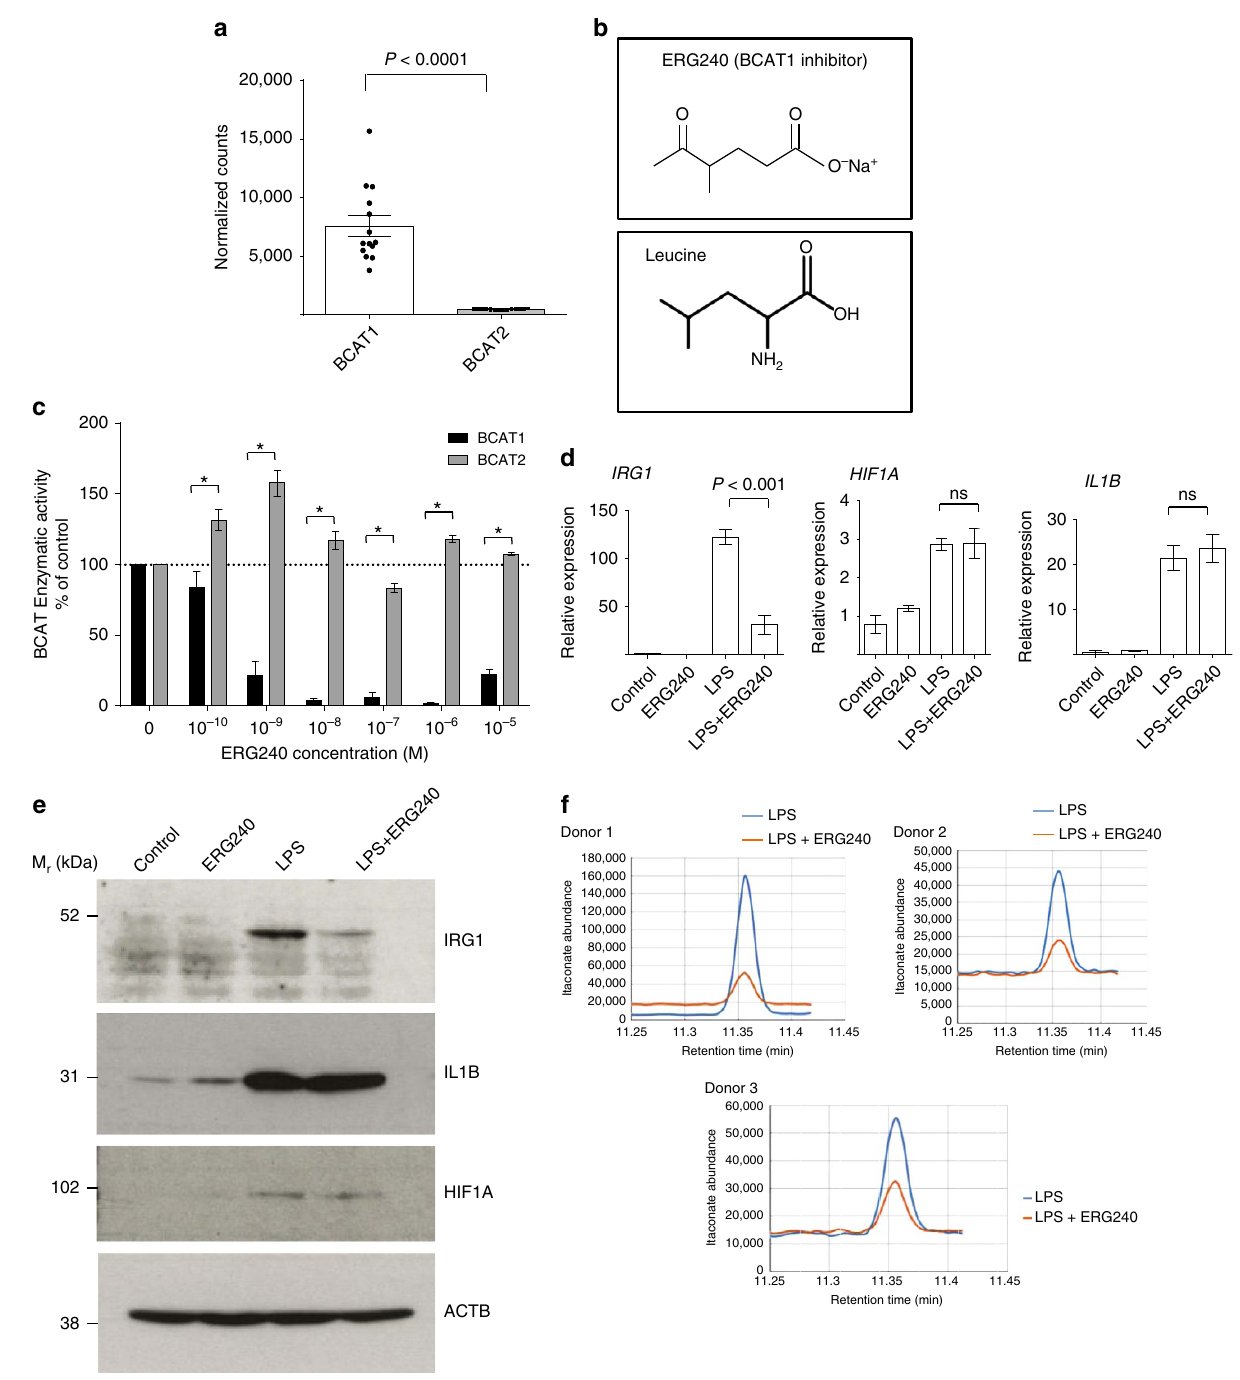
Figure 1 | BCAT1 expression and inhibition in human macrophages. ( a ) RNA-sequencing in human monocyte-derived macrophages (hMDMs) shows mRNA copies of BCAT enzymes in normalized counts. n ¼ 14 healthy donor hMDMs were used for RNA-seq. ( b ) Chemical structure of ERG240 and leucine. ( c ) Enzymatic activity of recombinant human BCAT1 and BCAT2 in presence of ERG240. ( d ) Relative expression of IRG1 , HIF1A and IL1B measured by qRT-PCR in control, ERG240-treated (20mM, 3h), LPS treated (100ngml (cid:2) 1 , 3h), and LPS þ ERG240 treated (LPS, 100ngml (cid:2) 1 ; ERG240, 20mM for 3h) hMDMs. ns, non-significant. All expression values are normalized to those obtained for HPRT gene expression. n ¼ 3 healthy donor hMDMs were used in each group. ( e ) Western blot analysis of IRG1, IL-1 b , HIF-1 a and beta-actin (ACTB) in control (untreated), ERG240-treated (20mM, 3h), LPS treated (100ngml (cid:2) 1 , 3h) and LPS þ ERG240 treated (LPS, 100ngml (cid:2) 1 ; ERG240, 20mM for 3h) hMDMs. The experiment is representative of three independent experiments using n ¼ 3 healthy donor hMDMs each. ( f ) GC/MS results showing itaconic acid production in hMDMs in presence or absence of ERG240 (20mM). LPS treatment was for 8h (100ngml (cid:2) 1 ). GC/MS plot for each donor is shown separately where itaconate abundance denotes arbitrary units. Error bars are s.e.m. Significance was tested using two-tailed Student’s t -test or one-way ANOVA. * P o 10 (cid:2) 3 following two-way ANOVA.